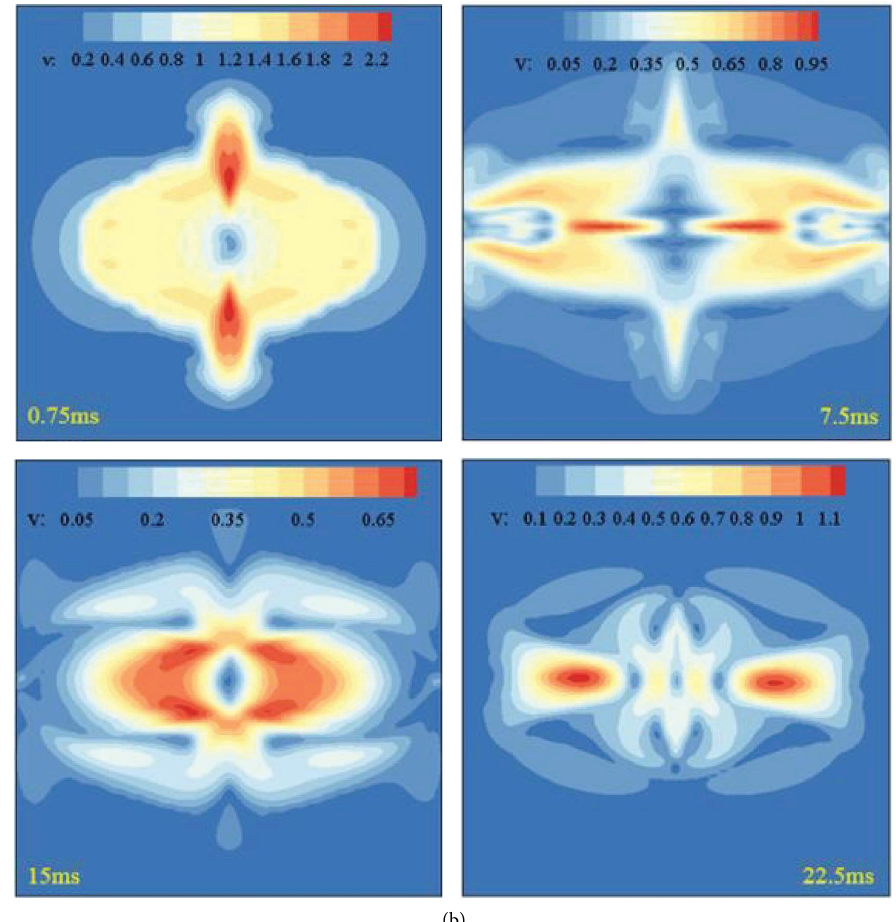
Figure 5: Cloud diagram of the droplet collision velocity (initial temperature 393K). (a) Te initial velocity is 0.5m/s. (b) Te initial velocity is